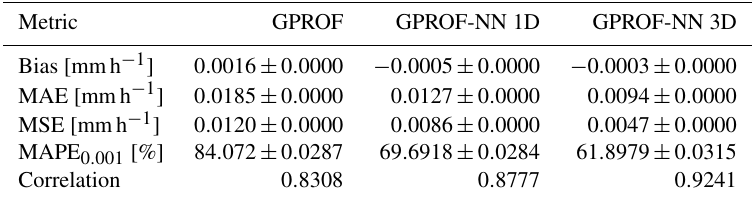
Table C2. The same as Table 4 but for RWP.